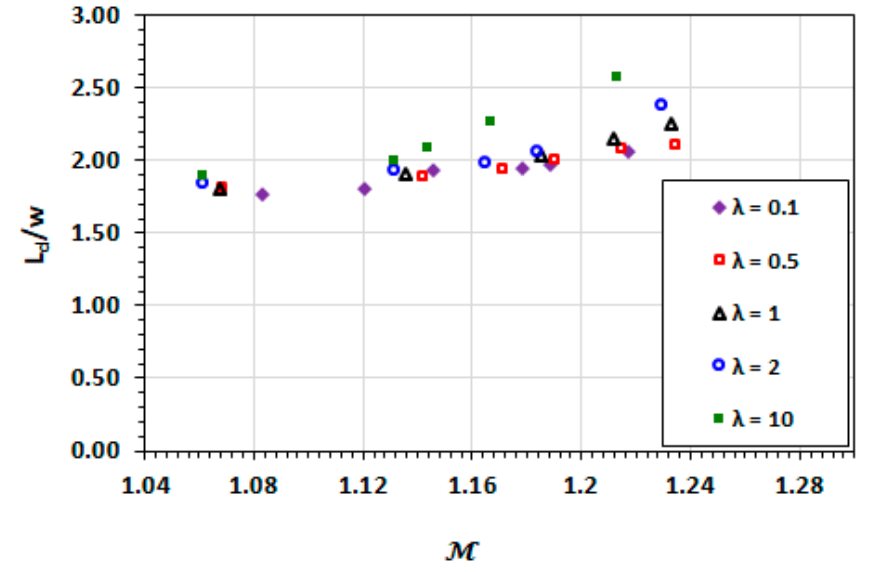
Figure 12. Dependence of the non-dimensionalised length on droplet mobility at varying viscosity ratios.